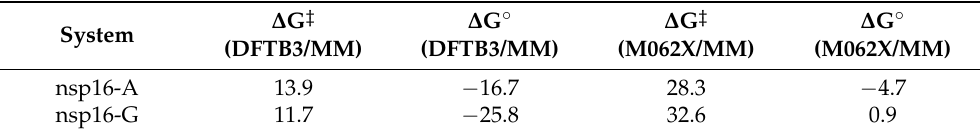
Figure 4. Representative structures of the TS for nsp16-A ( left ) and nsp16-G ( right ) systems. Representative snapshots from QM/MM umbrella sampling molecular dynamics simulations. Note that only atoms in the QM region are shown. Table 1. Activation-free energy ( ∆ G ‡ ) and reaction-free energy ( ∆ G°) for nsp16-A and nsp16-G. DFTB3/MM and its corrected value at M062X-D3/6-31+G(d,p) level are presented. All values in kcal·mol − 1 .